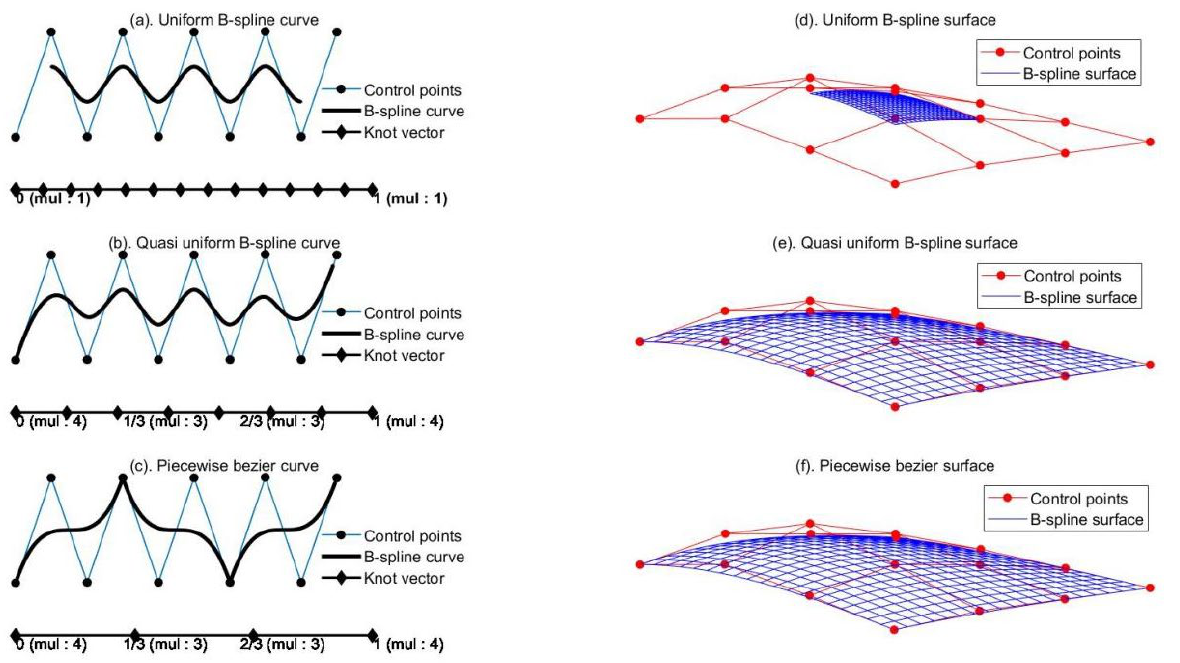
Figure 3. B-spline fitting curve: ( a – c ); B-spline fitting surface: ( d – f )